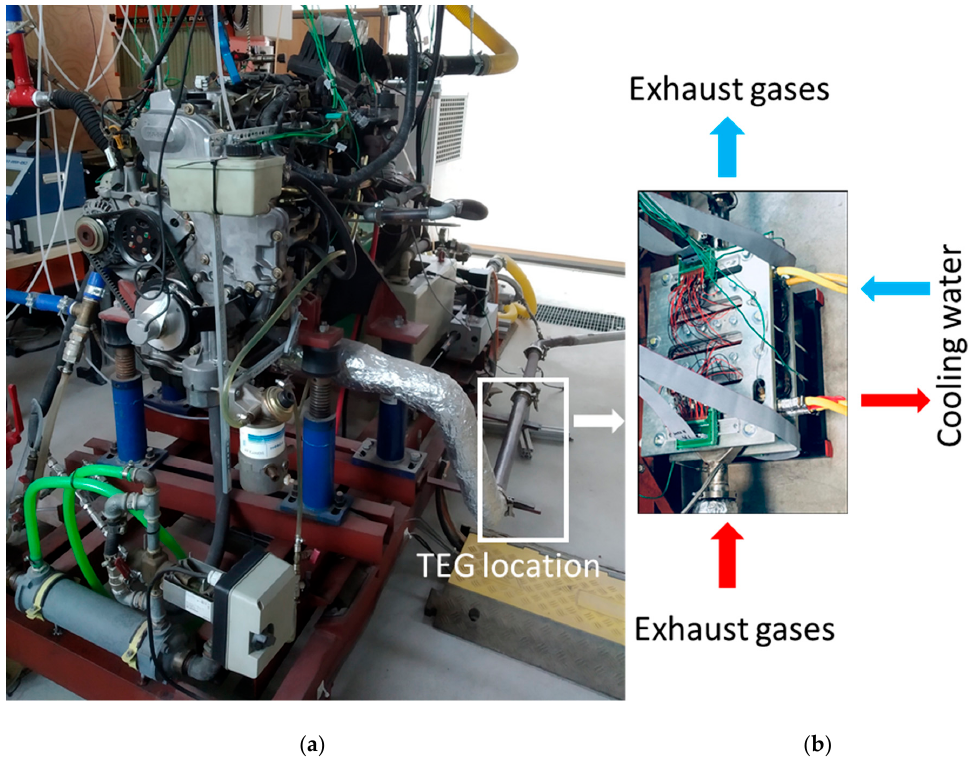
Figure 7. ( a ) Engine test bench and ( b ) the thermoelectric generator coupled to the exhaust pipe.